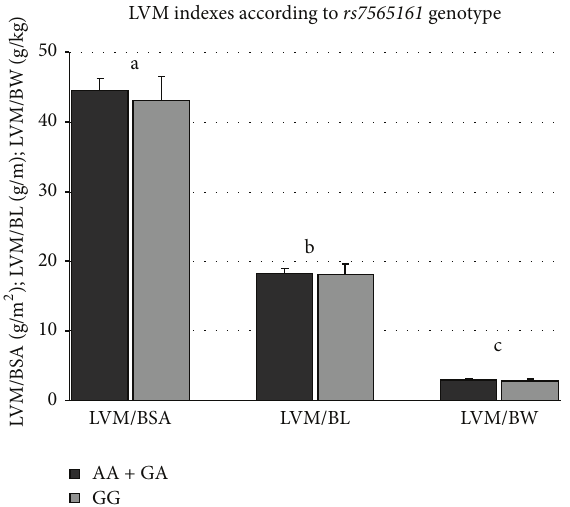
Figure 1: LVM indexes according to rs7565161 genotype. Mean and SEM are shown. a 𝑃 = 0.574 ; b 𝑃 = 0.795 ; c 𝑃 = 0.404 ; a , b , c AA + GA versus